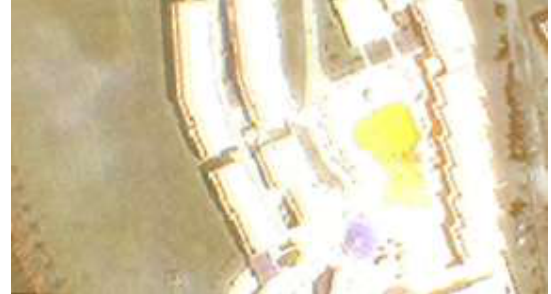
Figure 3. QuickBird image of “Scene 2” at spatial resolution 30cm/pixel.